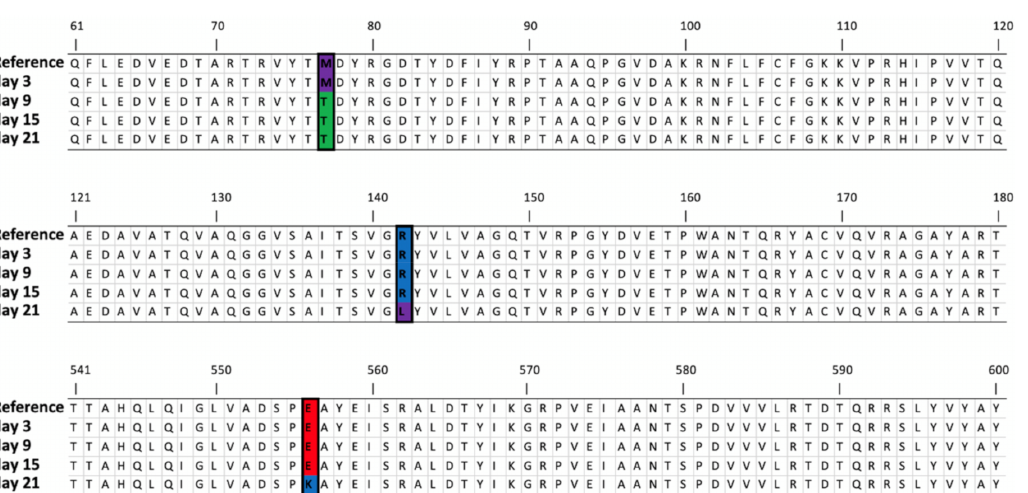
Figure 5. Amino acid sequences (61–180 and 541–600) of the tail tubular protein B and the mutations that appeared during the experiment (colored by polarity). Note: for simplicity, all mutations that occurred with more than 30% frequency at a certain time point are shown on the same protein sequence; this does not necessarily mean, however, that all the mutations occurred on the same specific protein